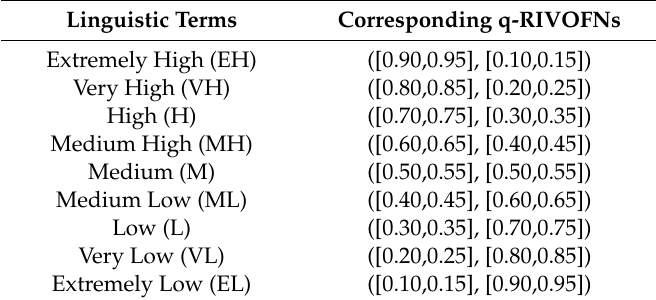
Figure 3. Structure of determining the best green supplier. Table 1. Linguistic terms and the corresponding q-rung interval-valued orthopair fuzzy numbers (q-RIVOFNs).